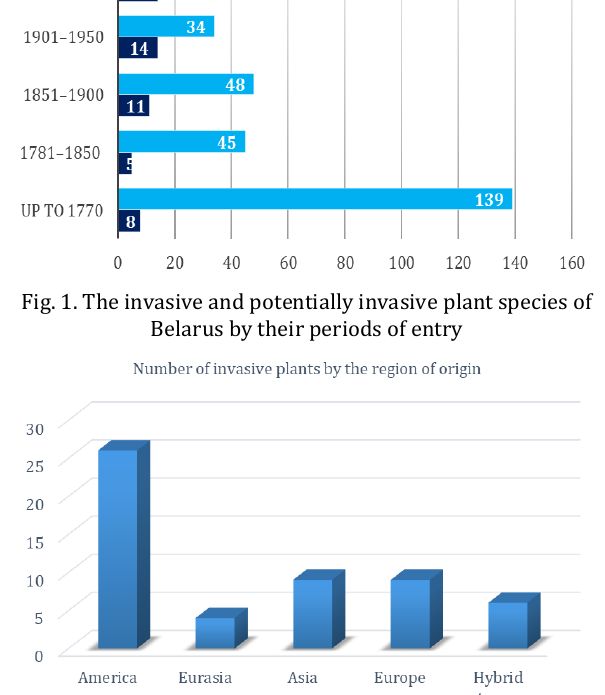
Fig. 2. Natural area (origin) of the invasive plant species of